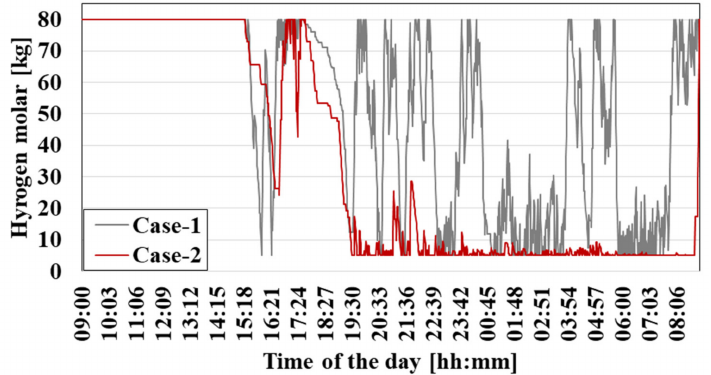
Figure 10. Hydrogen molar change in common hydrogen storage in Case-1, Case-2, Case-5 and Case-6.